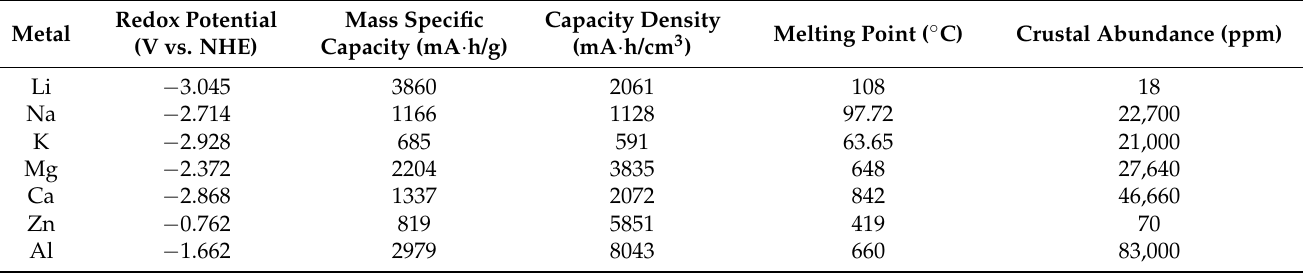
Table 1. Some physical and chemical parameters of several pure metal electrodes